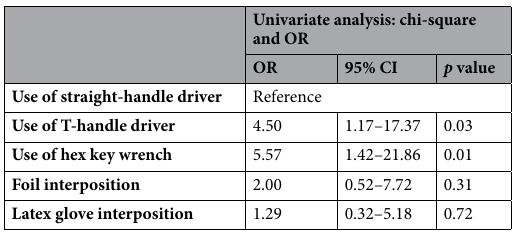
Table 2. Association between the use of different screwdrivers or interposition of materials and prevention of screw stripping. OR = odds ratio, 95% CI = 95% confidence interval.